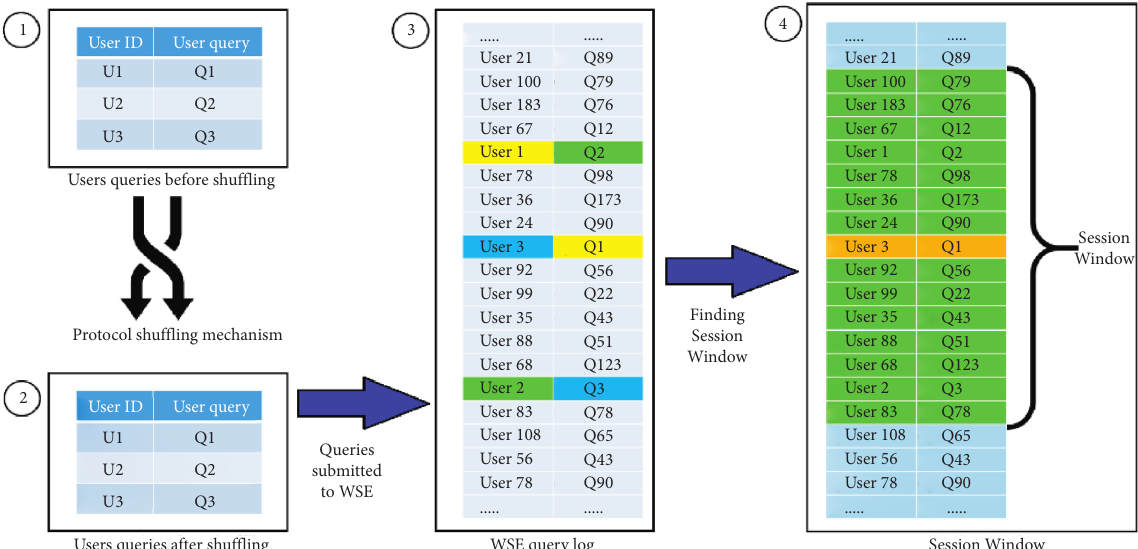
Figure 1: Queries entry in the weblog and Session Window